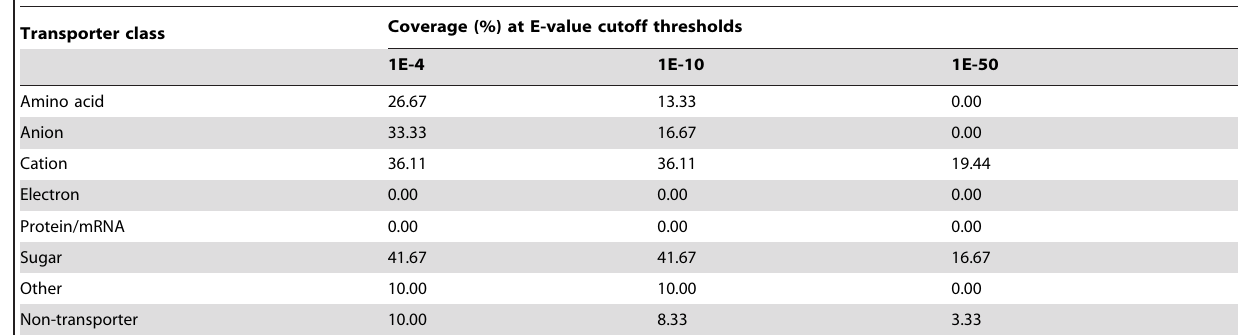
Table 9. The performance (coverage metric) of the PSI-BLAST search on the independent dataset.